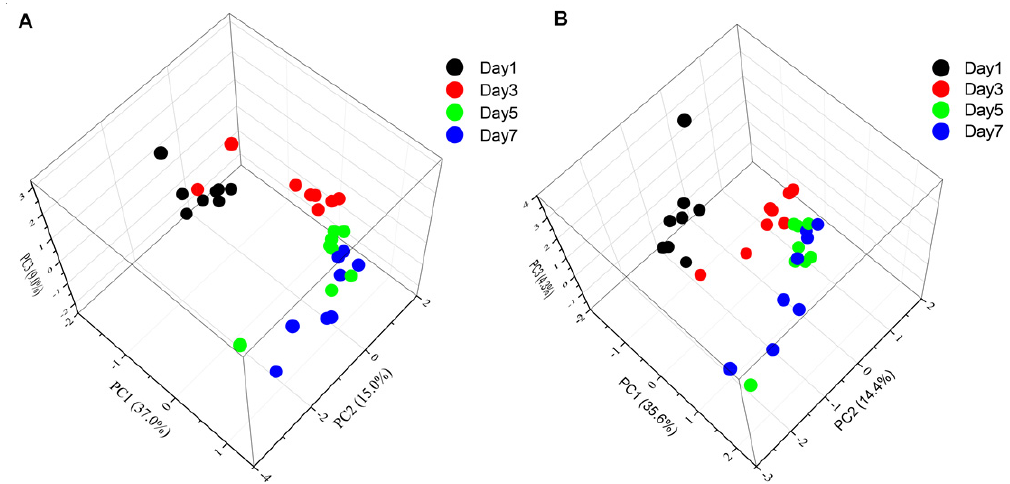
Figure 2. Principal component analysis (PCA) of the 32 samples based on metabolic peaks detected by positive ion mode ( A ) and negative ion mode ( B ). Different colors represent samples stored for different lengths of time.